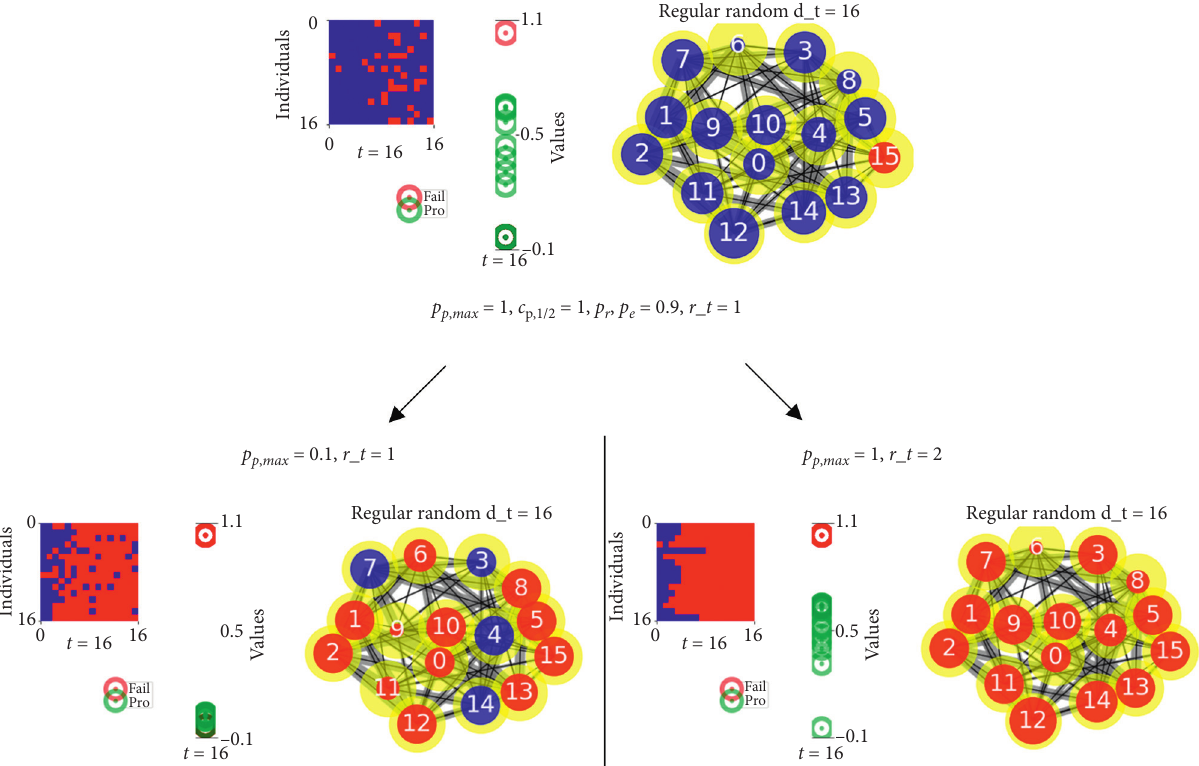
Figure 21: Representation of protection potential constructed by p t r (lower right-hand side). With the same p, max (lower set) and � 1 , c � 1, p � 0 . 9 , p � 0 . 9 , C � 1), the set of plots represents the time delay (left- initialized parameter values (upper plots: p p, p, 1/2 r e max hand side: r_ t � 1; right-hand side: r_ t � 2) case. In each section, the plot on the left-hand side shows a matrix (horizontal axis � time step from 1 to 16; vertical axis � individuals from 1 to 16; color of the matrix � failure state: failure [red] and absence of failure [blue]) corresponding to the parameter values of each individual at the given time step ( t � 16: red: fail � failure; green: pro � protection potential). The graph on the right-hand side represents their dynamics in a random regular network; node number � random label of each node marked with a yellow background; lines � connections embedded by eigenvector centrality as the thickness; node color � states (failure � red; absence of failure �